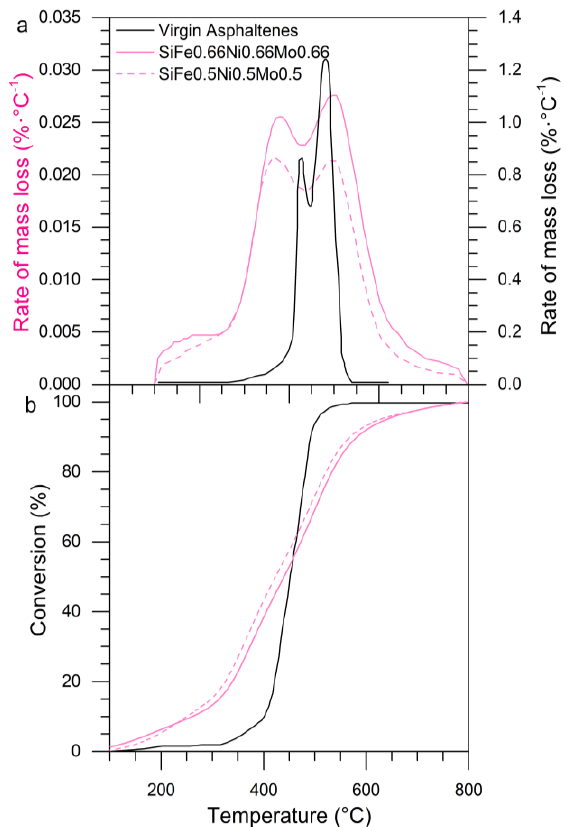
Figure 19. ( a ) Plot of the rate of mass loss as a function of temperature (DTG) and ( b ) conversion for virgin asphaltenes in the presence of three transition elements. Asphaltenes adsorbed amount of 0.2 mg·m −2 and heating rate of 10 °C·min −1.